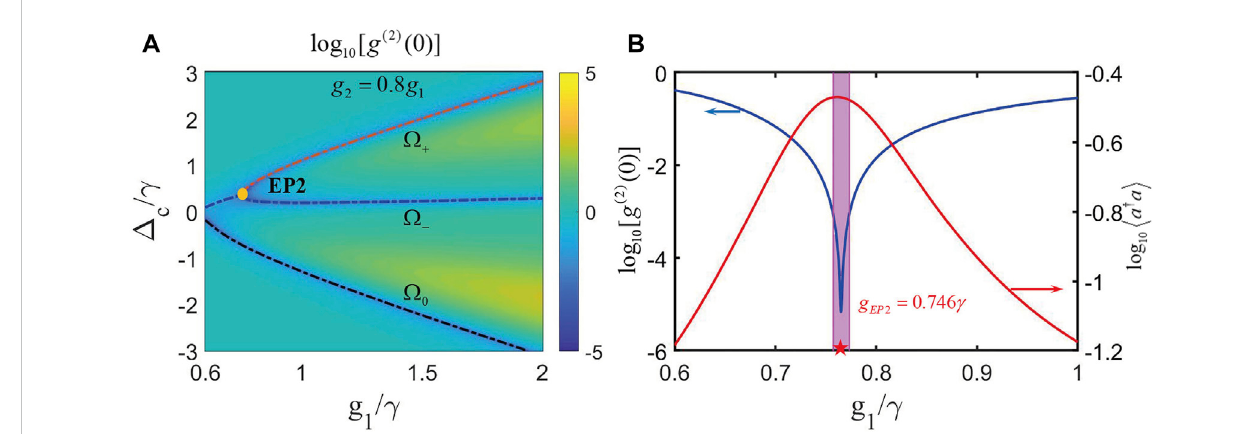
FIGURE 13 In the pseudo-Hermitian conditions when g 1 ≠ g 2 , EP3 is transformed into EP2. (A) The minimum value of g ( 2 ) ( 0 ) (see the blue areas) is in good agreementwiththerealpartsofsolutionsinEq.17,wheretheblackdashedlinedenotes Ω 0 andtheredandbluedashedlinesdenote Ω ± . (B) AroundEP2, the minimum value of g ( 2 ) ( 0 ) and the large mean photon number I c are achieved simultaneously, indicating the strong PB effect. We take the parameter as Δ c / γ (cid:1) 0 . 43 , and the others are same as those in Figure 11.